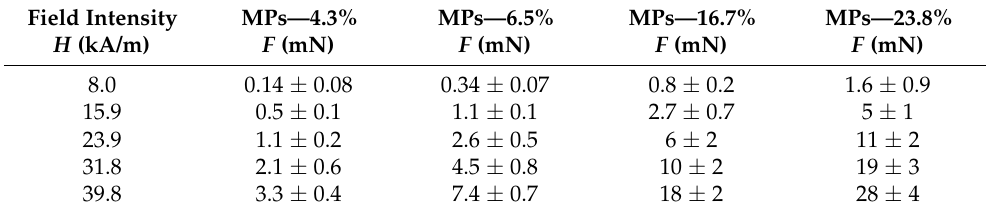
Table 1. Measurements of force of attraction in FG samples under study at different strengths of magnetic field. Mean values ( n = 3) and SD are